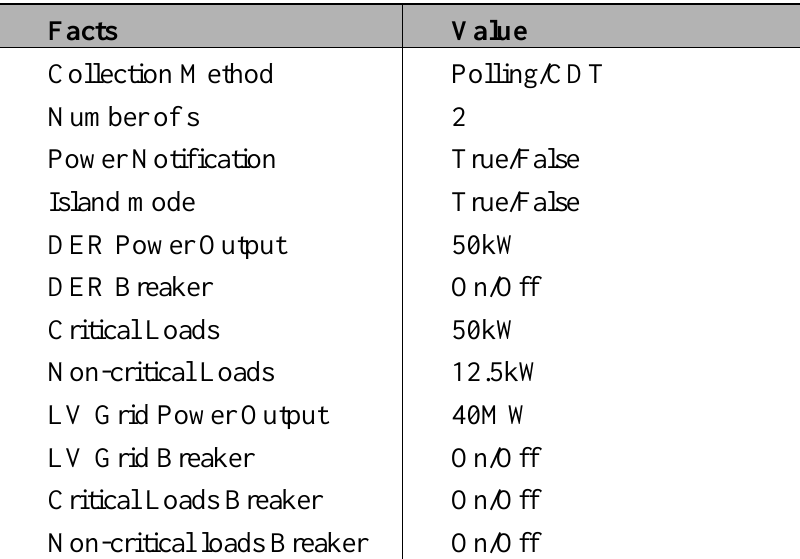
Table 2. Key facts in the hierarchical MAS.